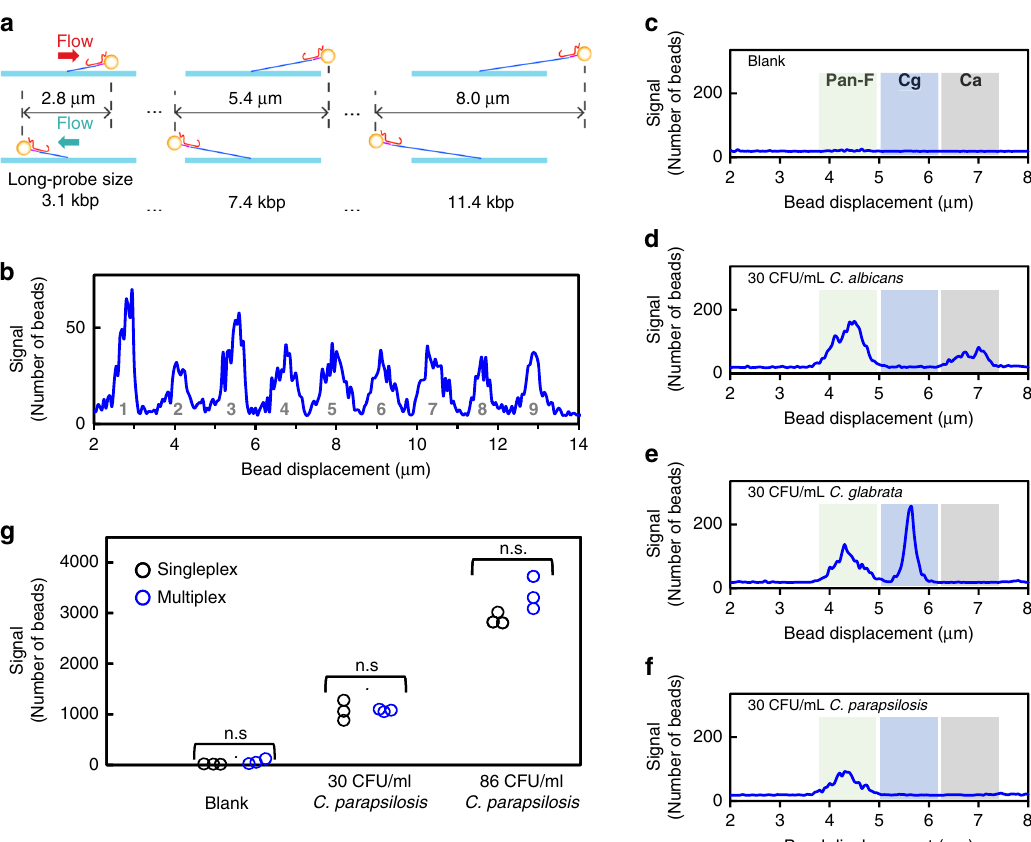
Fig. 3 SMOLT multiplex detection. a Strategy for detection of multiple targets in a single reaction and single capillary. Each target is detected with a Long Probe of a different length. Beads tethered by a Long-Probe move a distance that is correlated to the Long-Probe length and can be differentiated from beads tethered with probes of a different length based on displacement. b Demonstration of SMOLT multiplexing by detecting rRNA targets using nine Long-Probes of different lengths that generate nine unique peaks in the histogram of bead displacement. Peaks 1 – 9 correspond to Long-Probes with